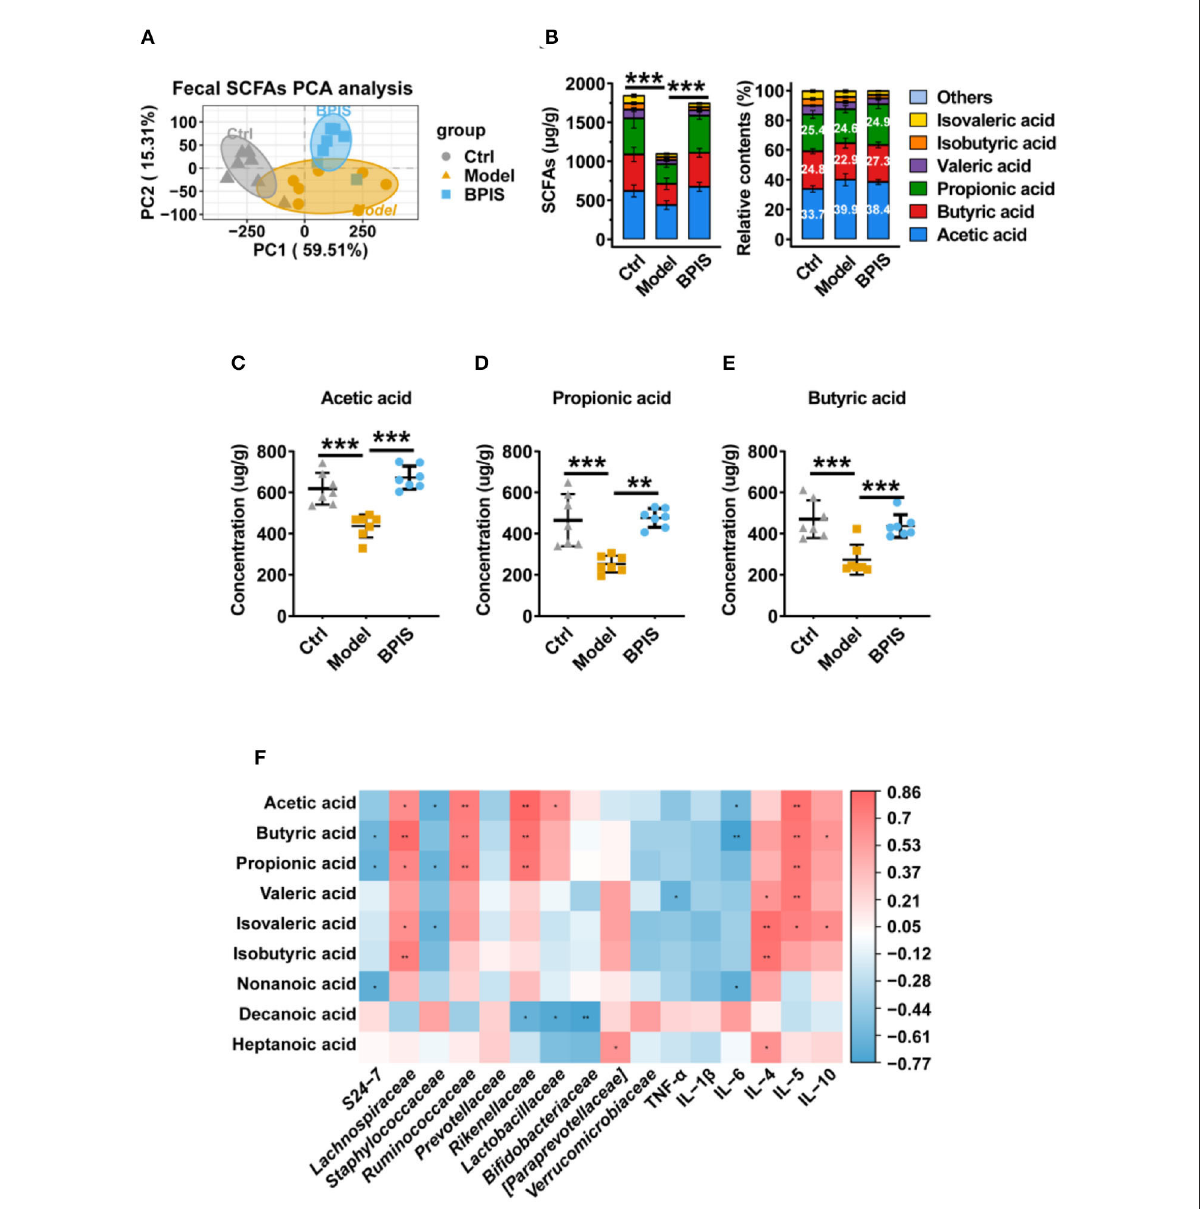
FIGURE7 Effects of BPIS on fecal levels of SCFAs in DSS-colitis mice. (A) The absolute contents of SCFAs in the proximal colon from DSS-induced and BPIS - gavage-DSS-induced samples were used for principal components analysis. (B) The absolute and relative contents of SCFAs in the proximal colon from mice samples were sequentially collected and were detected using high-resolution gas chromatography and mass spectrometry (GC-MS). (C–E) The concentrations of acetic acid, propionic acid, and butyric acid. (F) Correlation analysis among gut microbiota, inflammatory cytokines, and colonic SCFAs. Data are presented as the means ± SD ( n ≥ 5) and were analyzed by an ordinary one-way ANOVA with Tukey’s multiple comparisons. * p < 0.05, ** p < 0.01, *** p <